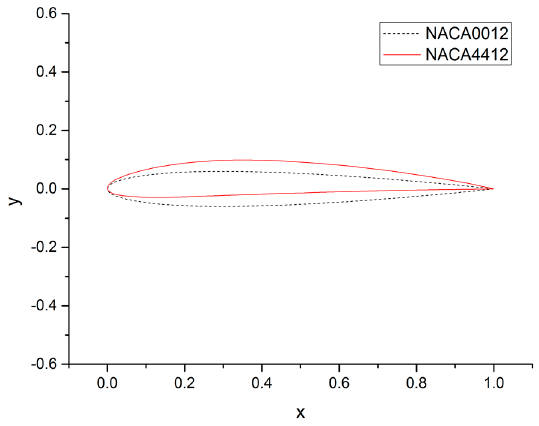
Figure 14. Airfoil change in test case 3.